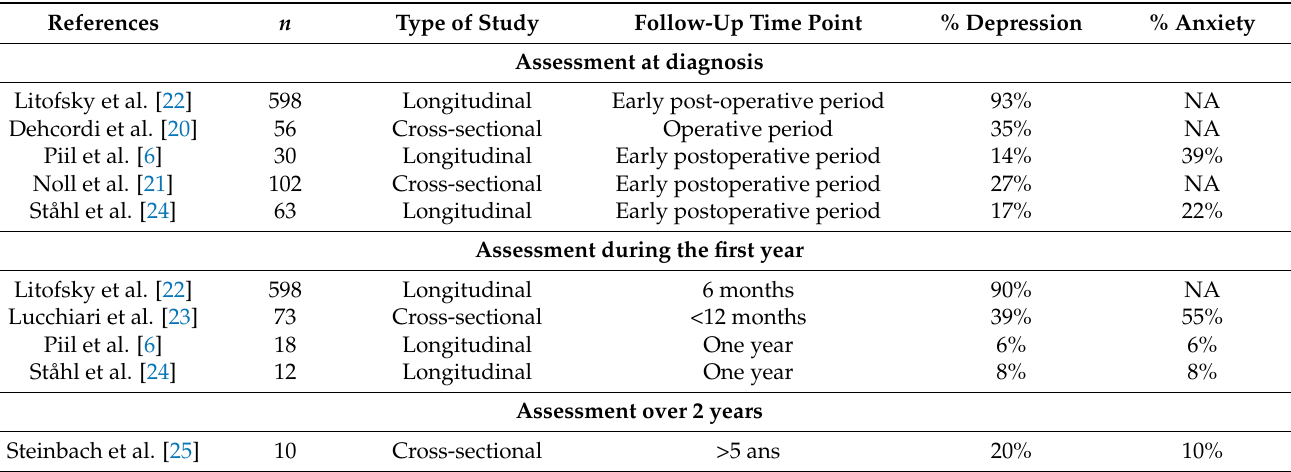
Table 1. Prevalence of depression and anxiety symptoms in persons with high-grade glioma, accord- ing to self-reported measures from the